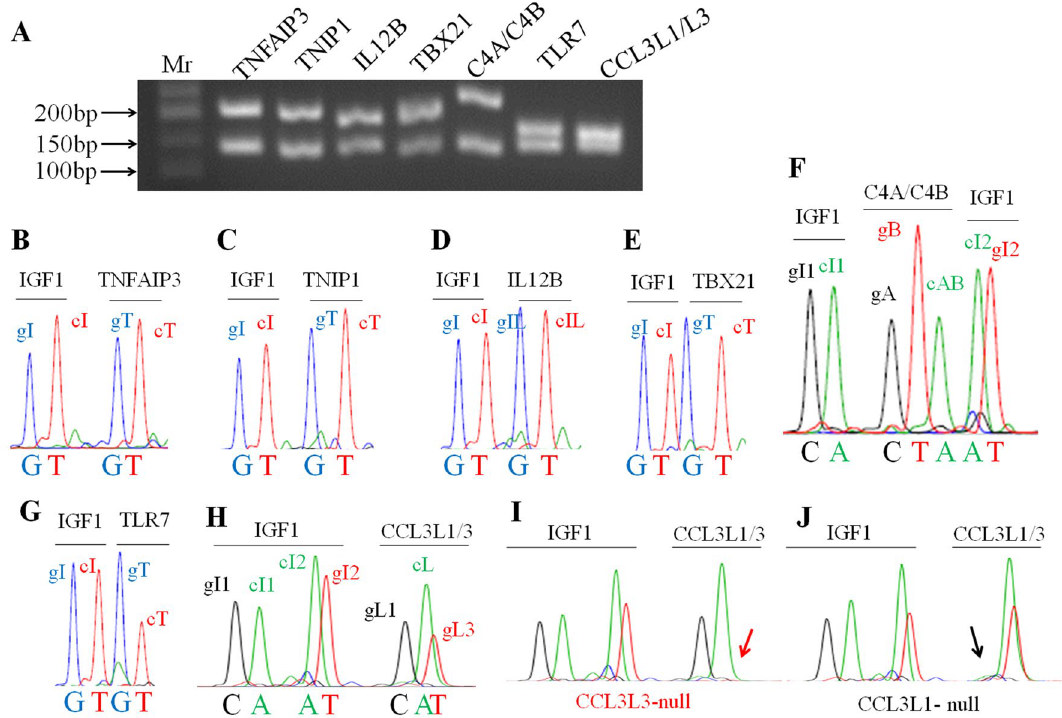
Figure 2. Representative results of mrcPCR assays. ( A ) Agarose gel electrophoresis for PCR products obtained in the mrcPCR assays. Target genes amplified during the mrcPCR assay are shown. Mr. molecular weight marker. Representative mrcPCR results for TNFAIP3 ( B ), TNIP1 ( C ), IL12B ( D ), TBX21 ( E ), C4A/C4B ( F ), TLR7 ( G ), and CCL3L1/CCL3L3 ( H ). CCL3L3 -null ( I ) and CCL3L1 -null ( J ) cases are also shown. Signals from genomic and competitor sequences for the control gene, IGF1, are marked as follows: gI, gI1, and gI2 for signals from the genomic sequence; and cI, cI1, and cI2 for signals from the competitor sequence. Signals from the genomic and competitor sequences for the target genes are marked as follows: gT for signals from the genomic sequences of TNFAIP3 , TNIP1 , TBX21 , and TLR7 ; gIL for signals from the genomic sequence of IL12B ; gA, gB, gL1, and gL3 for those from the genomic sequences of C4A , C4B , CCL3L1 , and CCL3L3 , respectively; cAB and cL for those from the competitor sequences of C4A/C4B , and CCL3L1/CCL3L3 , respectively. ( I )